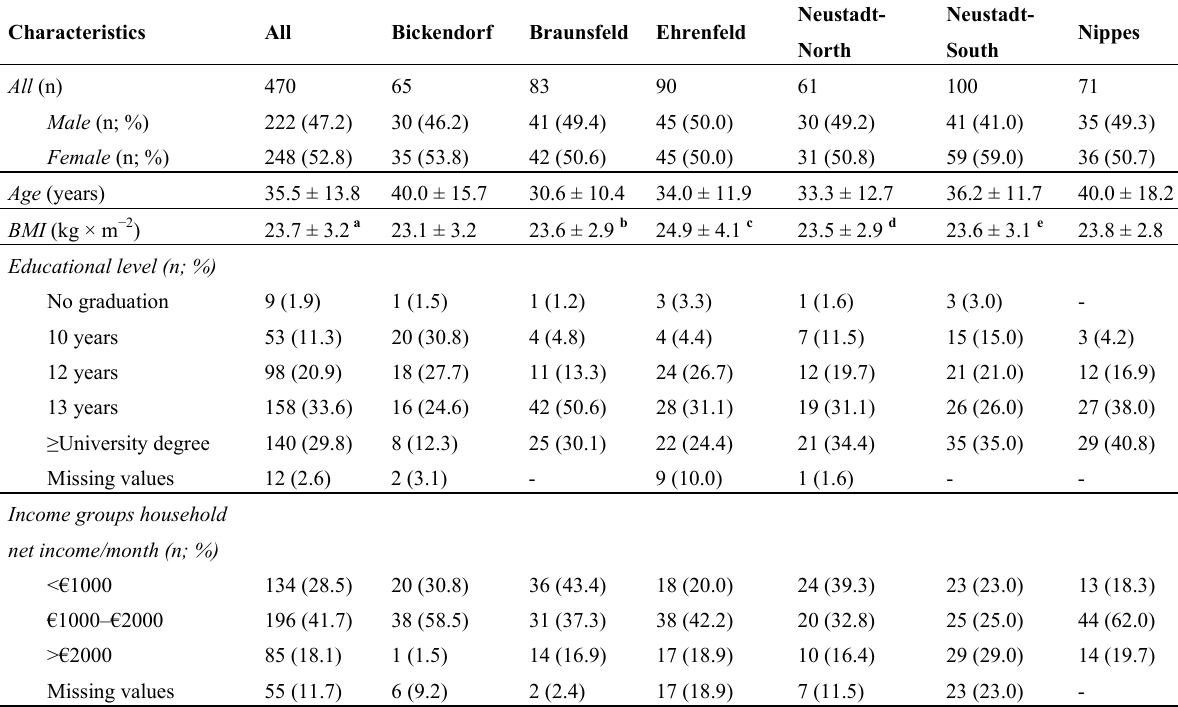
Table 2. Characteristics of overall sample and of subsample in selected city